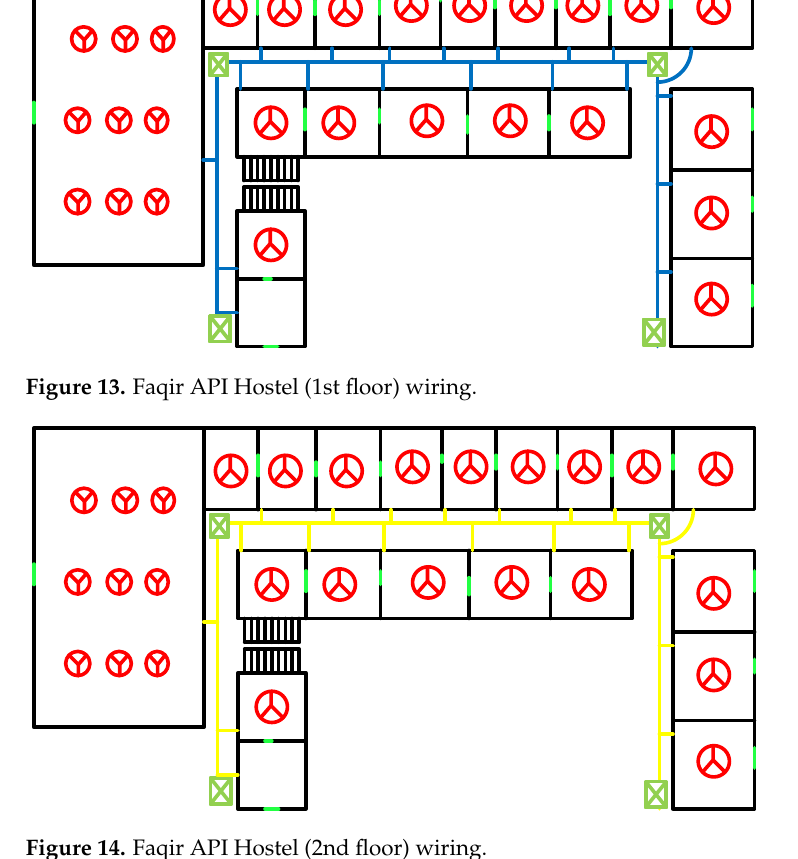
Figure 14. Faqir API Hostel (2nd floor) wiring.